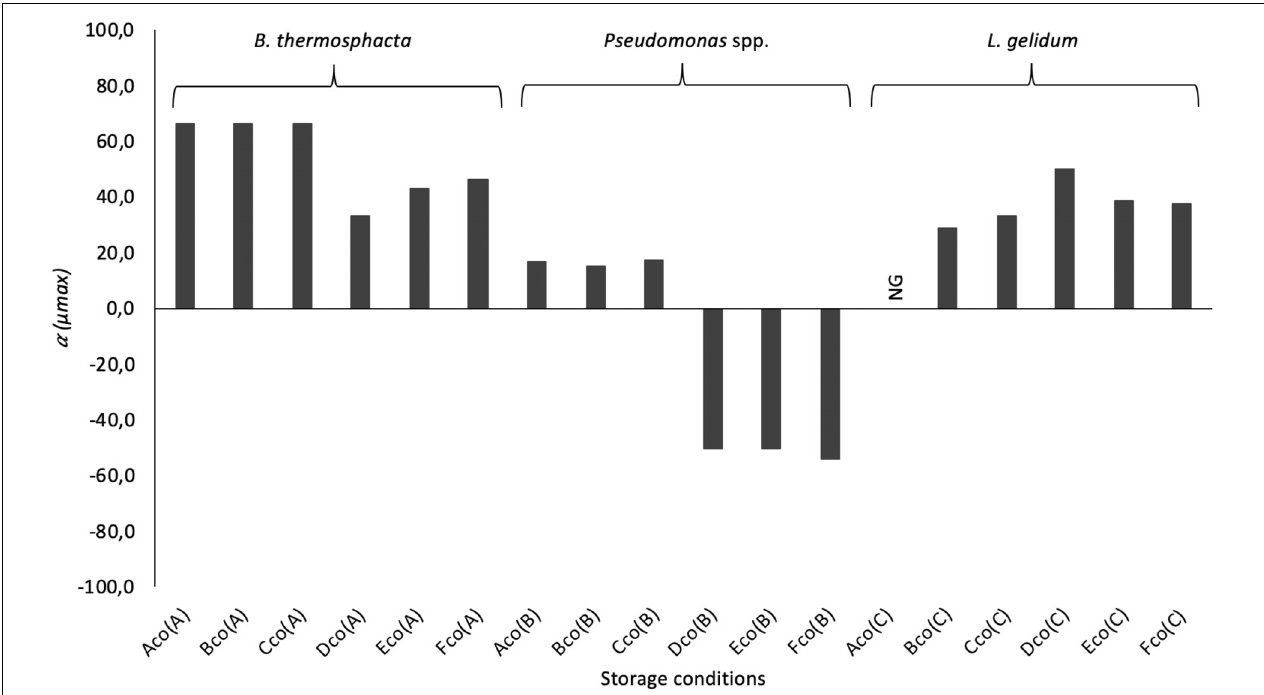
FIGURE 5 | Reduction ratio ( α ), in%, of the parameters µ max for B. thermosphacta , Pseudomonas spp., and L. gelidum in co-culture experiments at different storage conditions (see Table 1 for legend). The negative bars represent an increase in co-culture for the specific parameters. No growth of bacteria (NG) was only observed for Ln. gelidum in MAP at 4 ◦